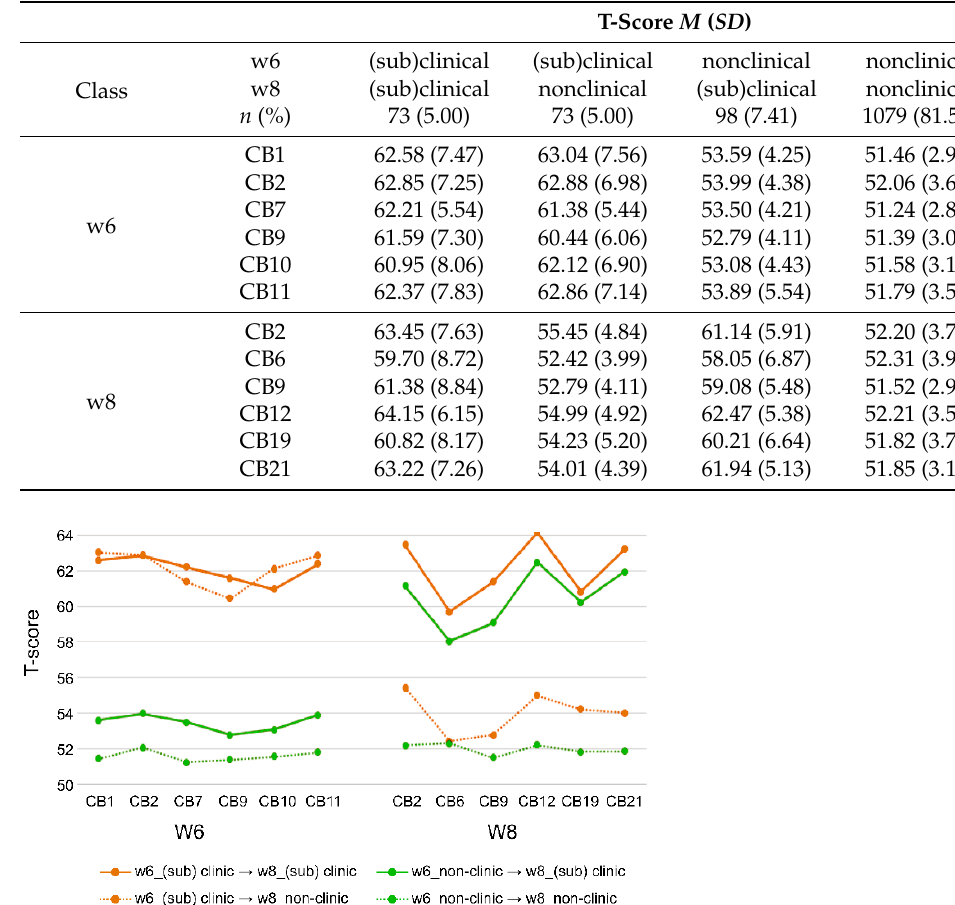
Table 3. The transition of nonclinical and (sub)clinical groups to nodes with high expected influences.